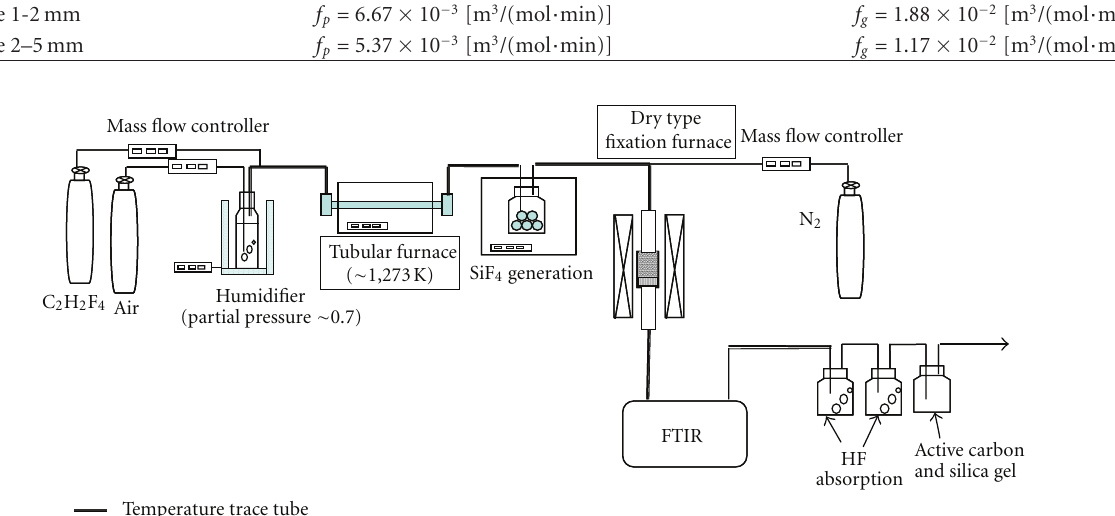
Figure 10: Experimental flow of the gas-solid reaction of SiF 4 and sodium